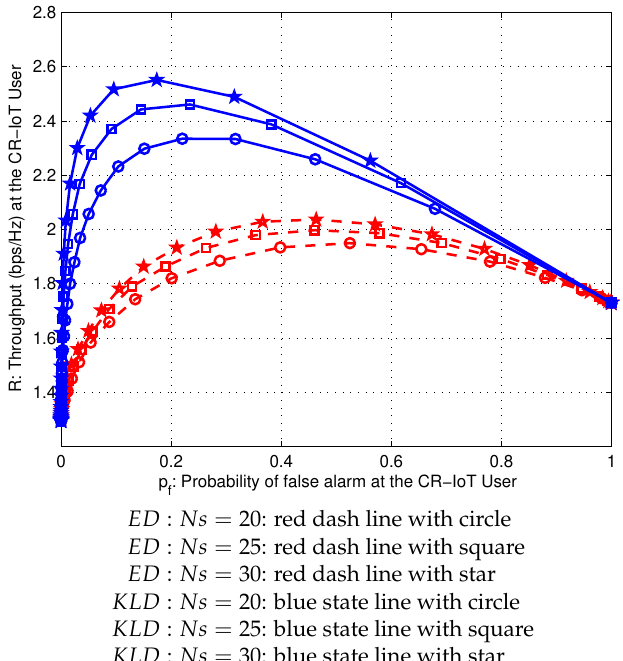
Figure 5. Sum rate curves versus probability of false alarm of CR-IoT user in conventional and proposed schemes when α =